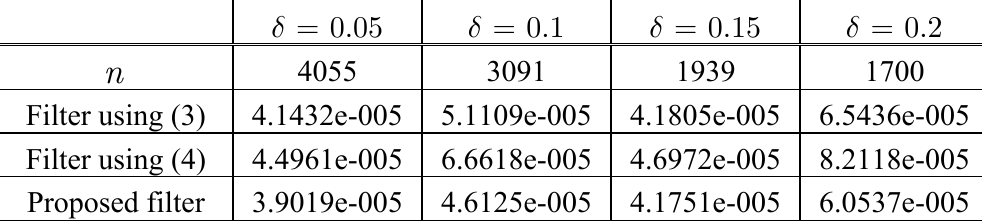
Table 3. Estimation error with different δ values in case